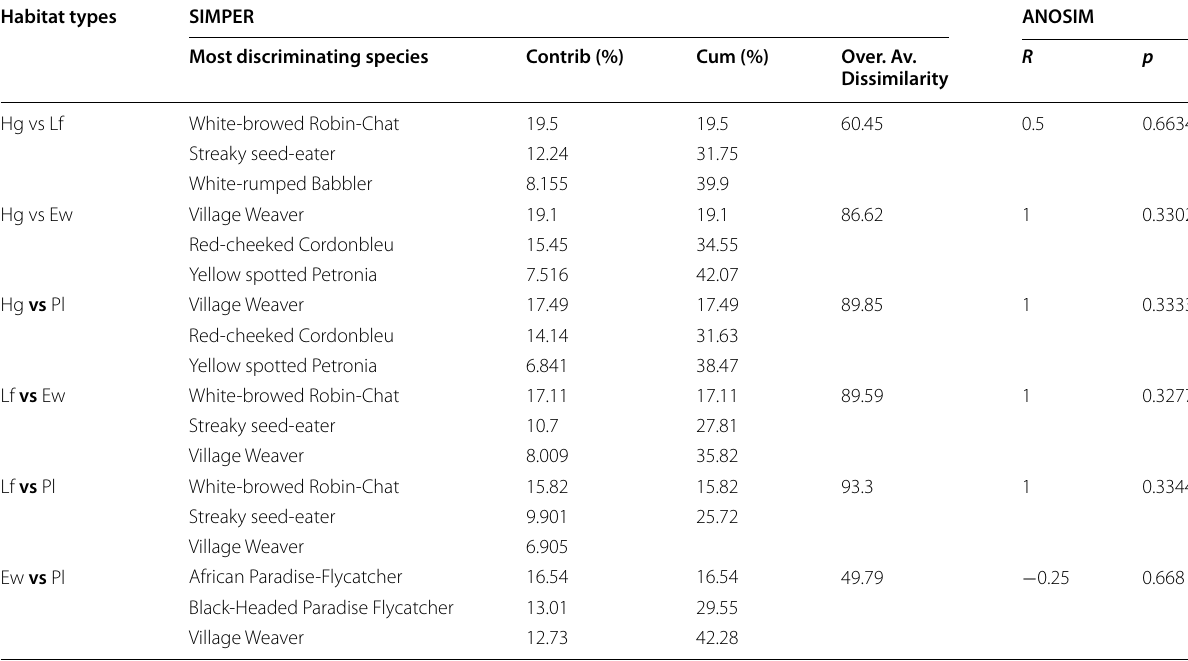
Only three species that contributed the most to the dissimilarity are shown. The average dissimilarity is the contribution of each species to the dissimilarity between the two groups according to Bray-Curtis similarity. Contribution % indicated the contribution of each species to the group pair dissimilarity in percentage values. Cumulative % indicates the cumulative value of the contribution of each species to the dissimilarity Contrib % Percentage contribution, Cum % Cumulative contribution, Over. Av Overall average dissimilarity, R Global R -value, P -value Significant value <